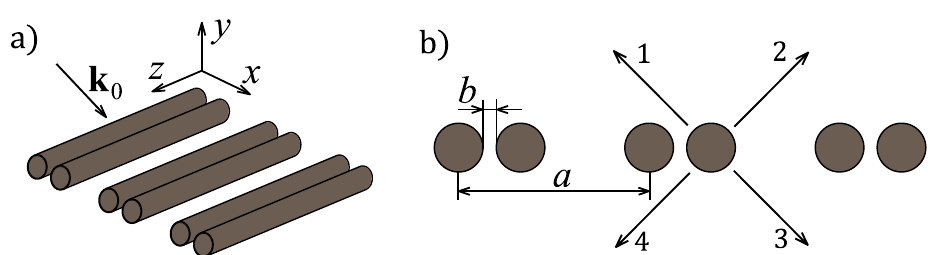
Fig. 1. The waveguide system. (a) The Cartesian coordinate system and incident wave vector and (b) geometrical parameters and possible directions of reflection and refraction are shown.